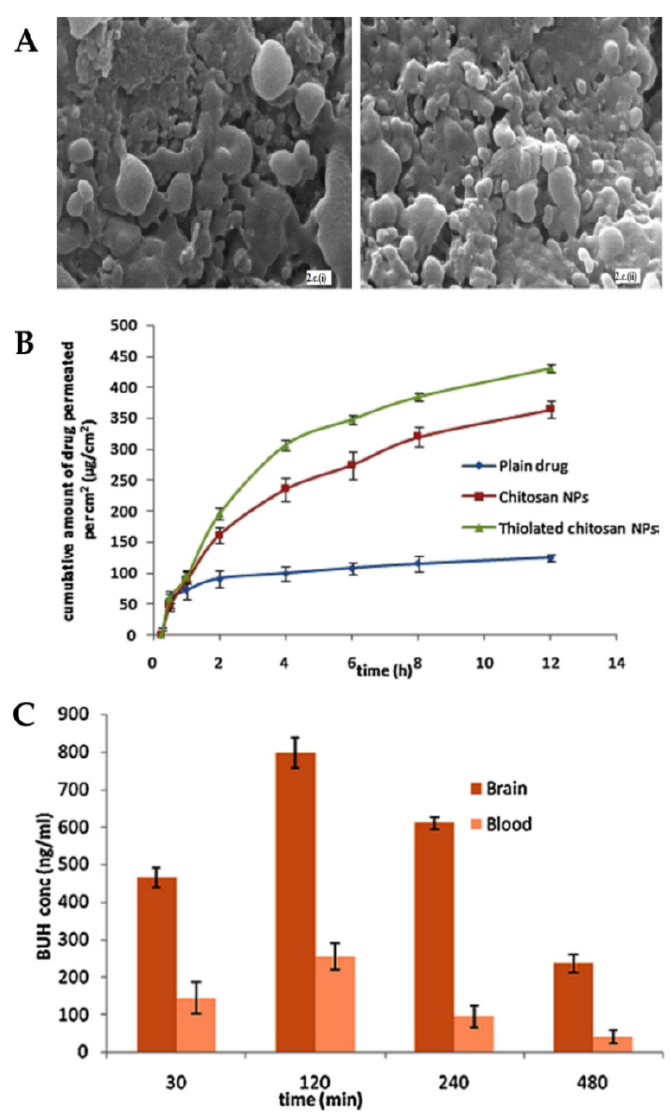
Figure 6. ( A )—Scanning electron microscope images of the buspirone chitosan nanoparticles (on the left (2.c.(i))) and thiolated chitosan nanoparticles (on the right (2.c.(ii))); ( B )—Ex vivo permeation study of buspirone chitosan nanoparticles (Chitosan NPs), thiolated chitosan nanoparticles (Thiolated chitosan NPs), and drug solution (Plain drug); ( C )—Buspirone brain and blood concentrations after intranasal administration of the thiolated chitosan nanoparticles; BUH—buspirone; conc—concentration; NPs—nanoparticles; adapted from Bari et al. [64], reproduced with permission from Elsevier [License Number 5426000697685].